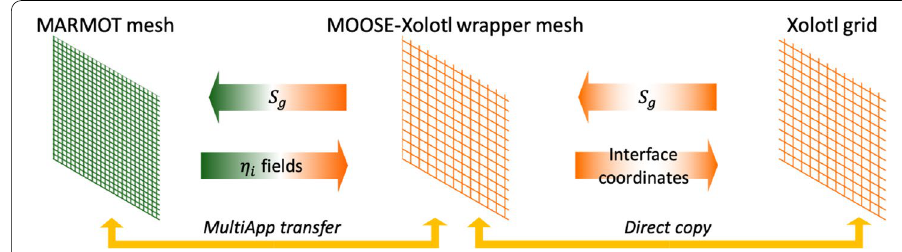
Fig. 2 Schematic of the data transfer approach used in the hybrid